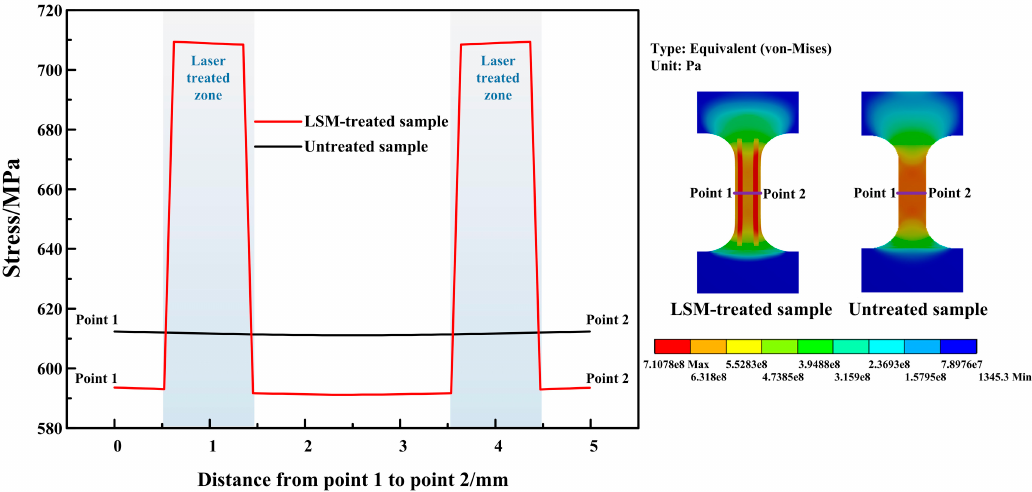
Figure 12. Stress distributions of specimens and stress value from point 1 to point 2 during tensile test.